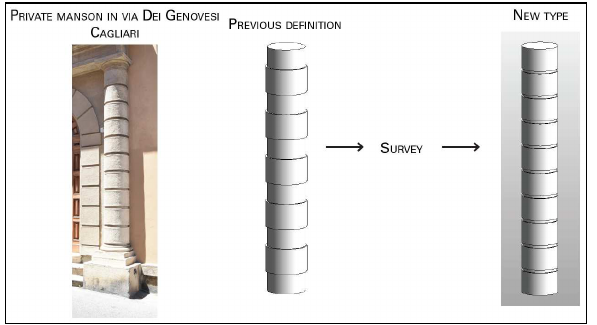
Figure 10. Application of the “Banded type” algorithm 3.4.2